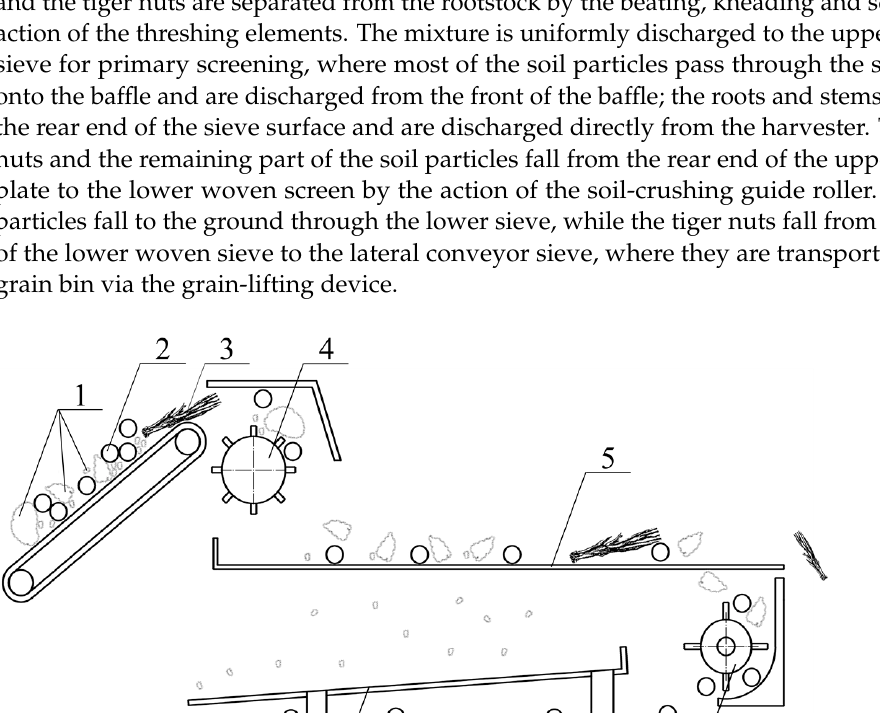
Figure 2. 3D model of the sieving device. 1. Tangential flow threshing drum 2. Linkage 3. Frame 4. Upper sieve 5. Guide drum 6. Lower sieve 7. Horizontal sieve.